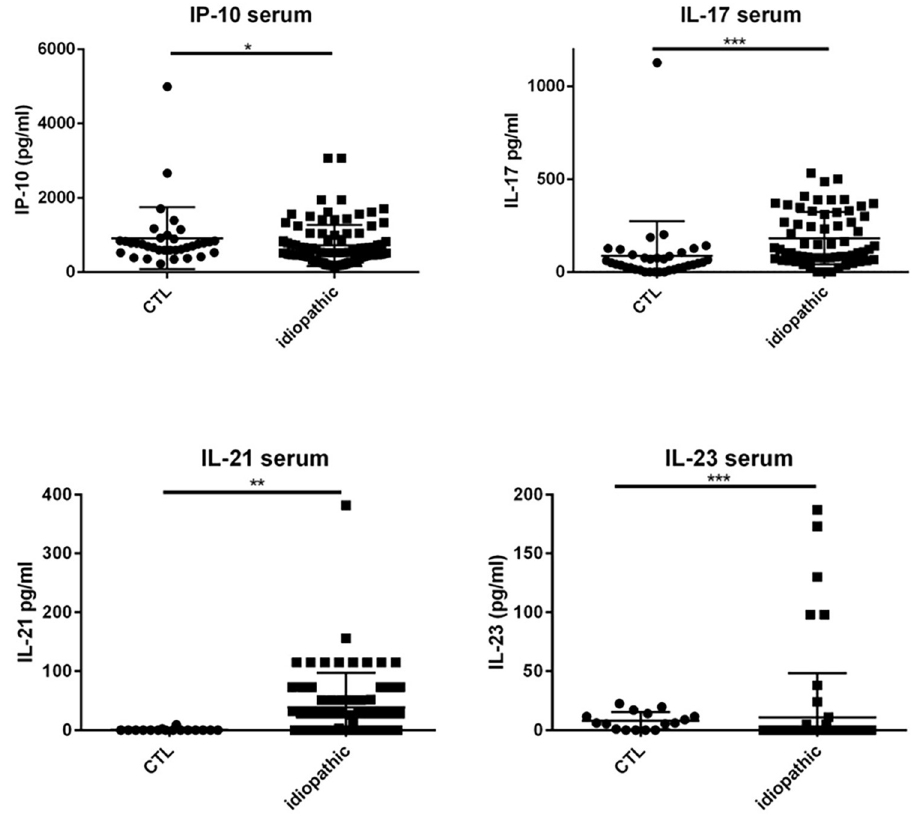
Fig 1. Dot plots of immune mediators, IL-17 and IP-10 in the serum. IL-17 and IP-10 in the serum are increased in patients with idiopathic uveitis (n = 63) compared with serum of noninflammatory controls patients (cataract age- related) (CTL) (n = 47). Medians levels for IL-21 and IL-23 in the serum: elevated for IL-21 and decreased for IL-23 in patients with idiopathic uveitis (N = 68) as compared with noninflammatory controls patients (cataract age-related) (CTL) (N = 16). � = P < 0.05 ; �� = P < 0.01; ��� = P <